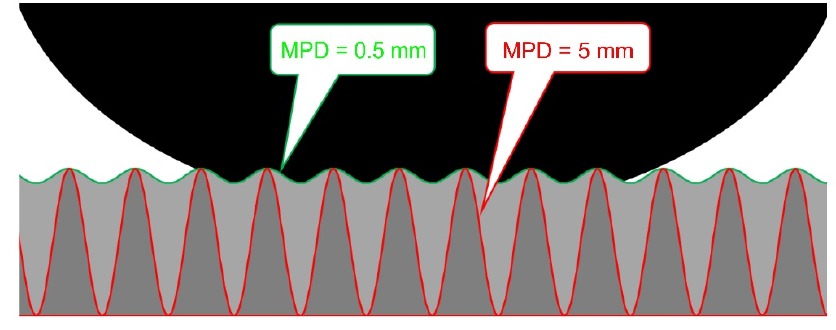
Figure 1. Tire enveloping on two very different road pavements.